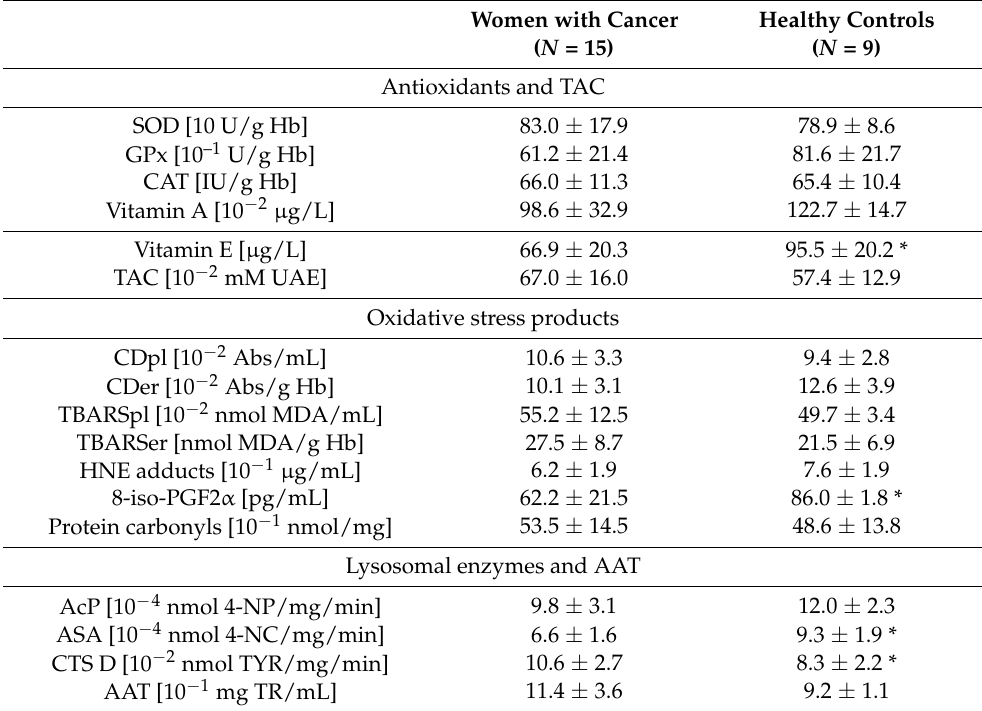
Table 2. Oxidant–antioxidant balance and activities of selected lysosomal enzymes, together with anti-protease activity in peripheral blood, in women with ovarian cancer.